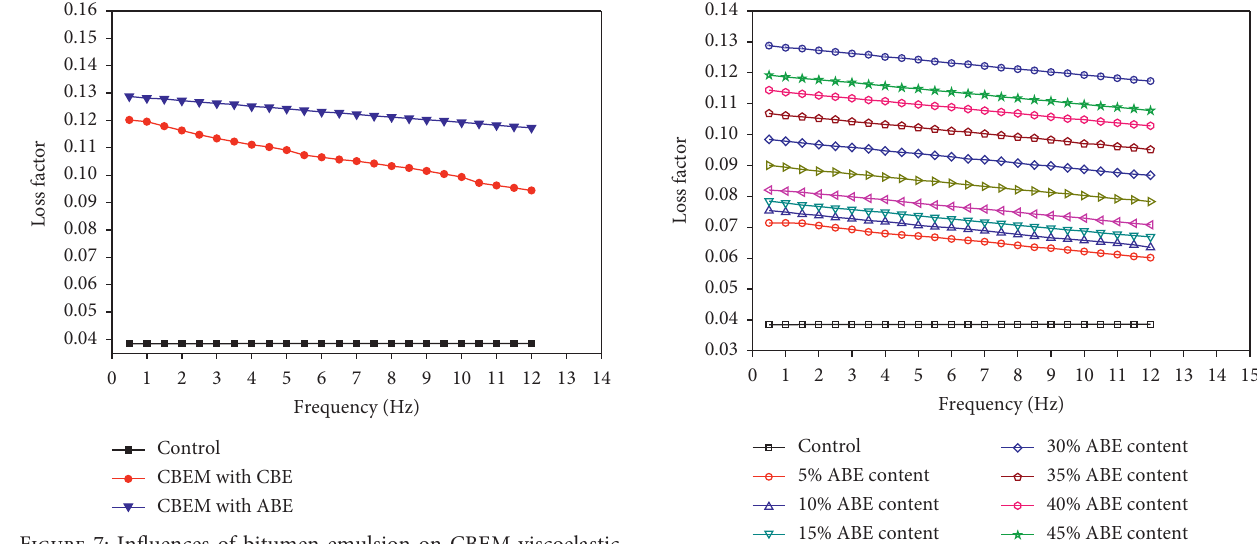
Figure 7: Influences of bitumen emulsion on CBEM viscoelastic property.